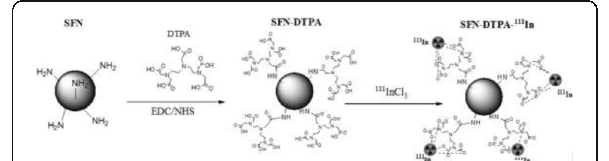
Fig. 1 (abstract PP05). See text for description